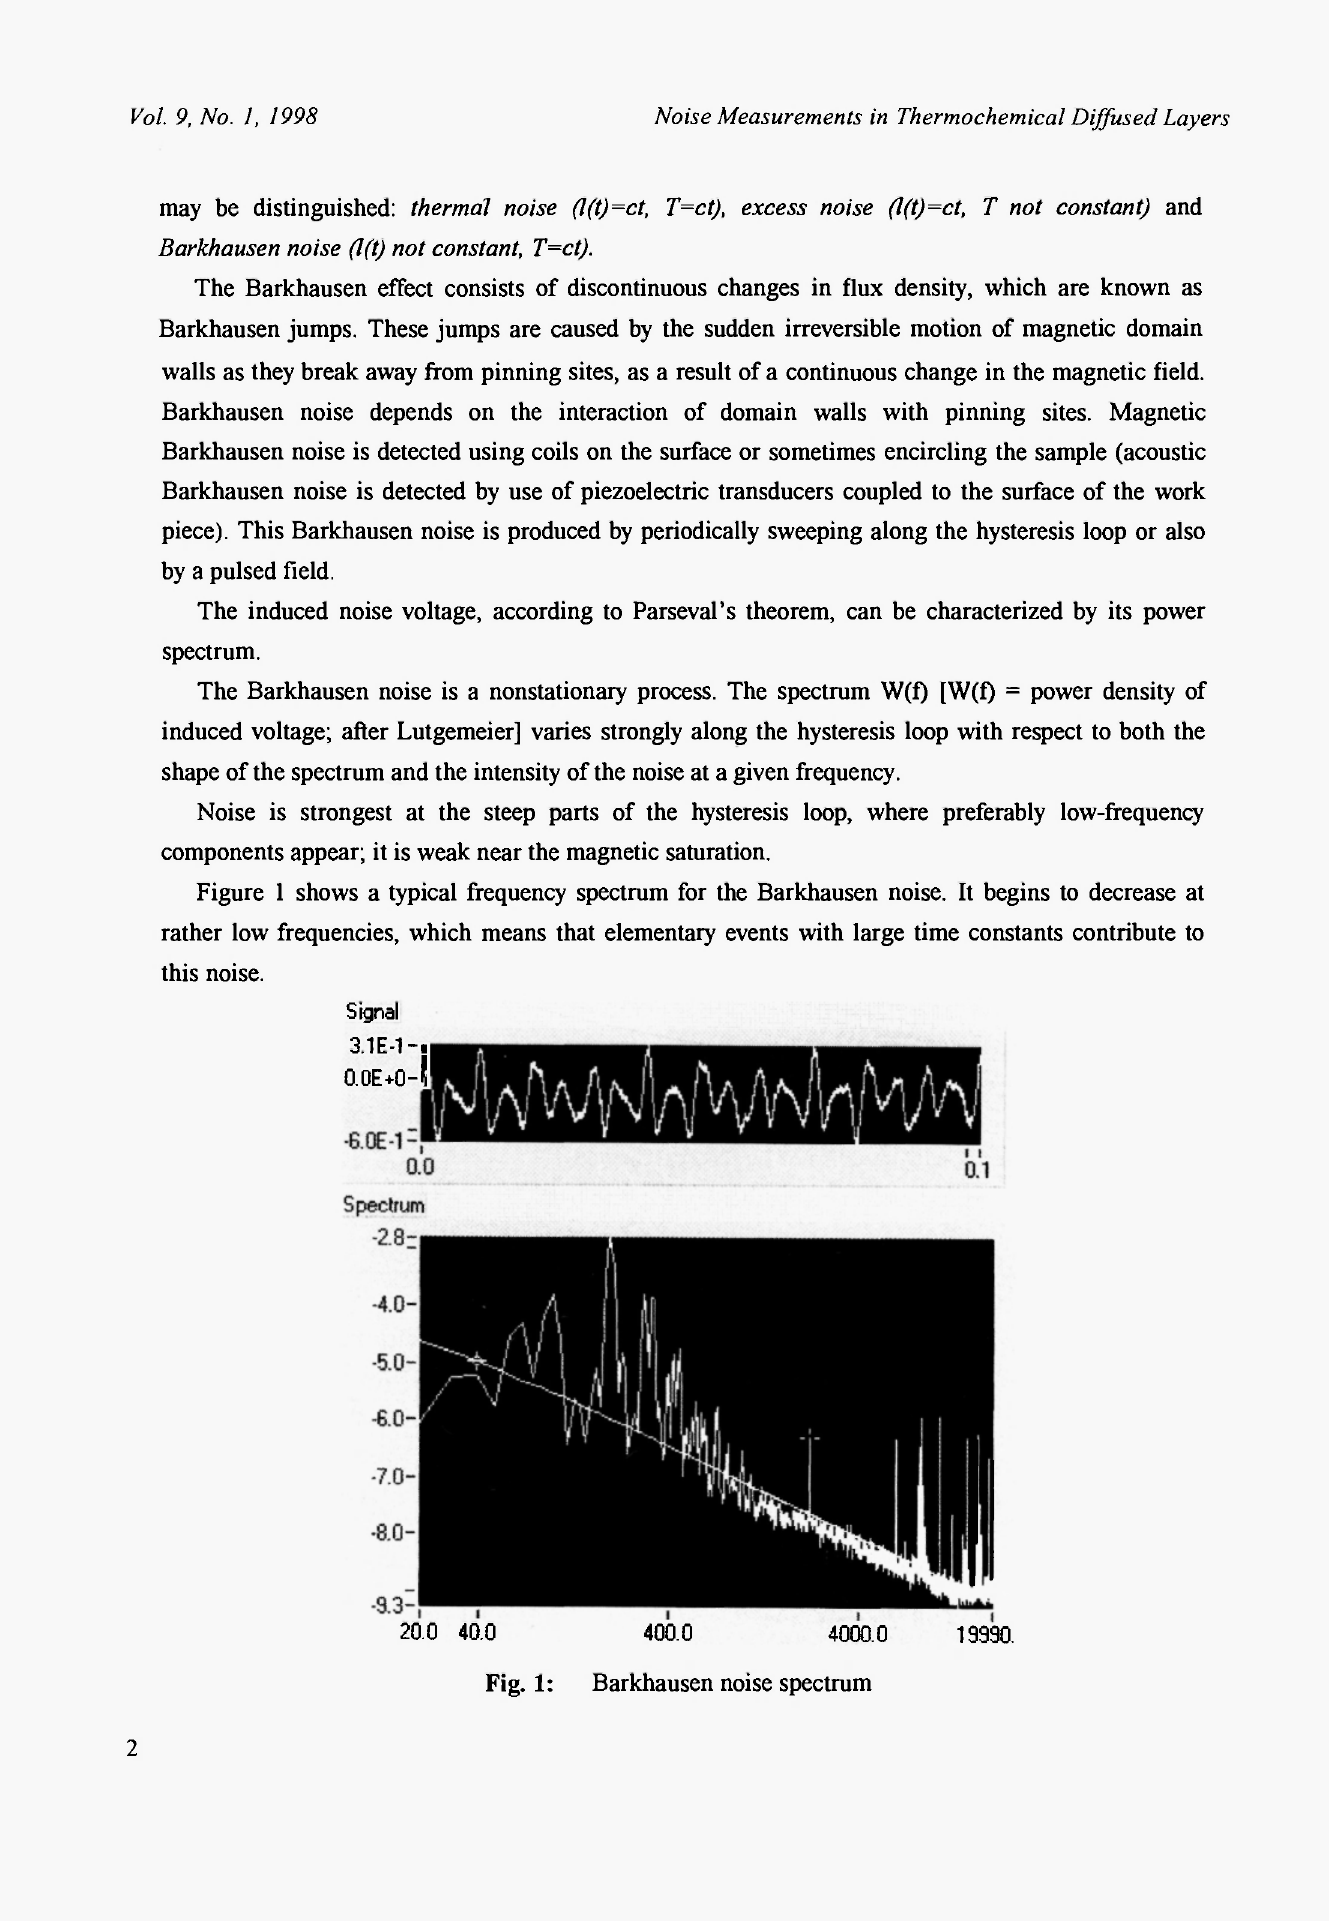
400.0 4000.0 Barkhausen noise spectrum Fig. 1: